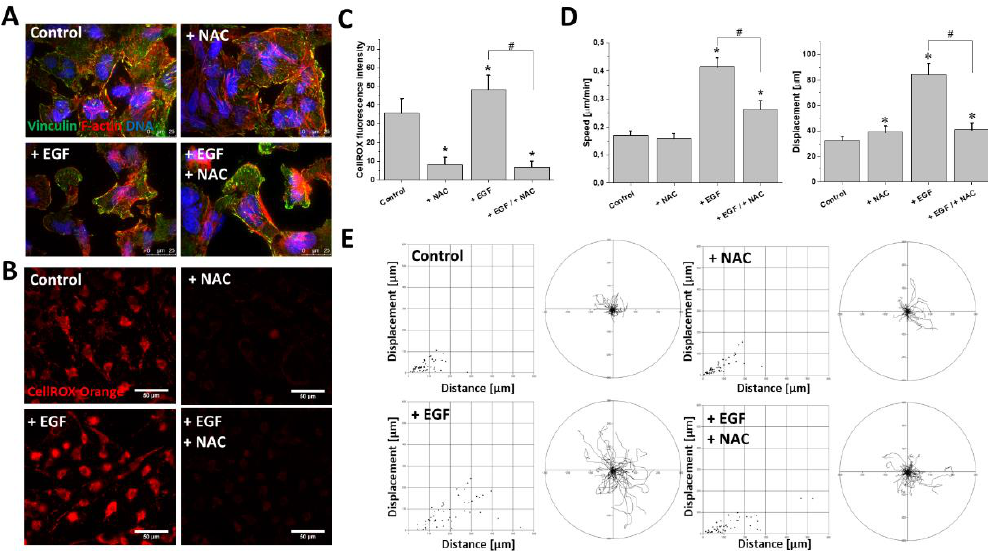
Figure 5. Effect of ROS scavenger N-acetyl-L-cysteine on EGF-induced enhancement of migration activity of GBM cells. ( A ) Decreased ROS levels in GBM cells did not attenuate EGF-evoked changes towards spindle-like morphology. ( B-C ) NAC (1 mM) strongly decreased mtROS production in examined GBM cells. ( D-E ) Effect of NAC on GBM cells’ motility in the presence/absence of EGF (10 ng/mL). Note the considerable attenuation of pro-migratory EGF activity upon intracellular ROS depletion. Bars represent S.E.M, n = 40 cells. Statistical significance was calculated with non-parametric Mann–Whitney test, * p < 0.05 vs. control; # p < 0.05 vs. reference condition. Scale bars = 25 µm ( A ) and 50 µm ( B )